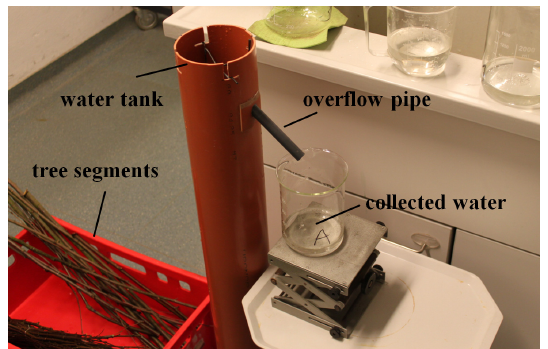
Figure 5. Experimental set-up. (C. Hess, Leuphana University Lüneburg)